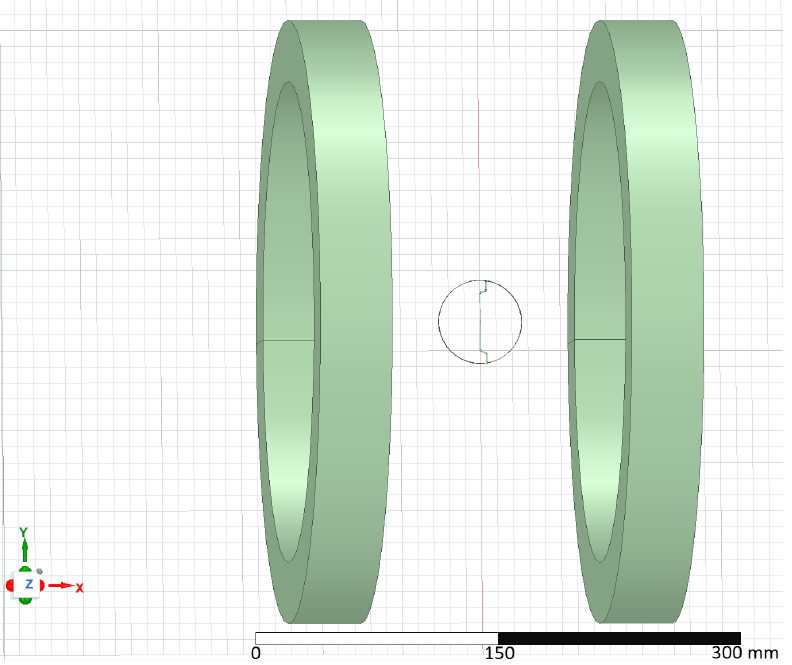
Figure 2. The simulation setup in ANSYS.